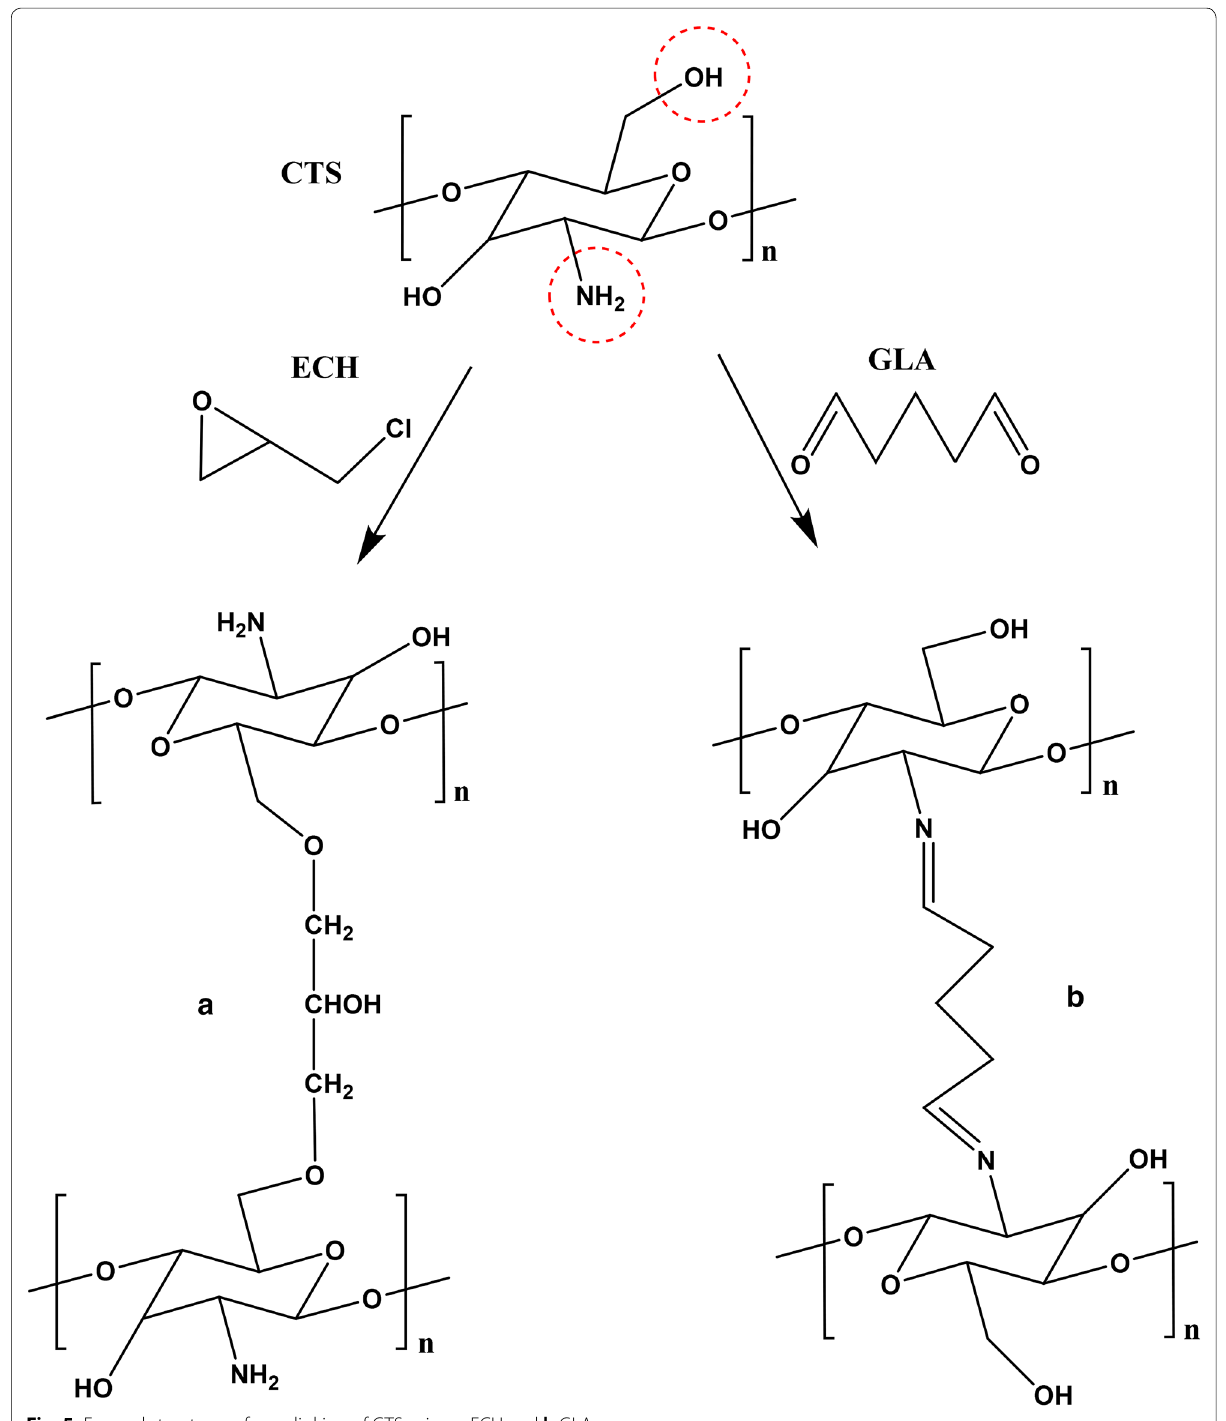
Fig. 5 Formed structures of crosslinking of CTS using a ECH and b